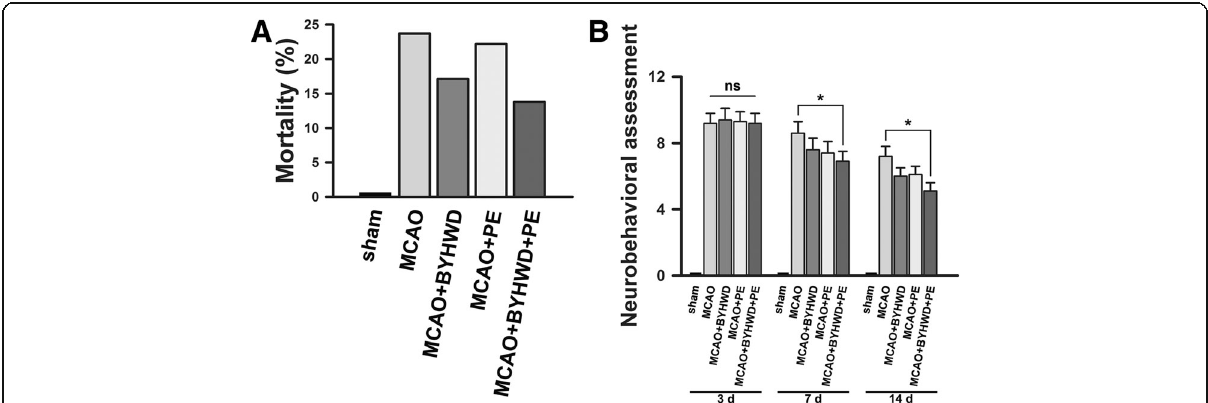
Fig. 2 Comparisons of the mortalities and neurobehavioral assessment in all groups. Mortalities of all groups ( a ). Evaluations of the neurological deficits in all groups ( n = 6 at each time point) ( b ). Scores of neurological deficits are expressed as the means ± standard error of the means; ns, not significant, p > 0.05; *, p < 0.05, compared to the MCAO